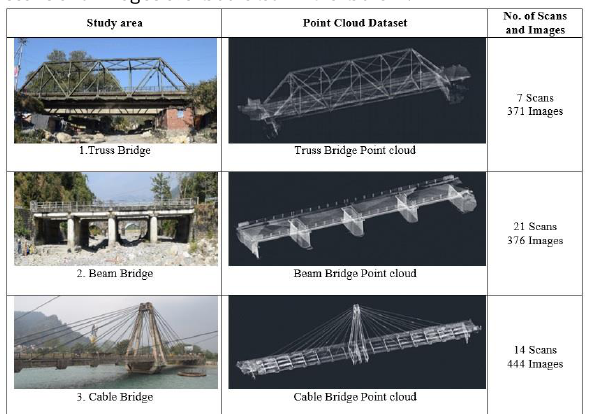
Table 1: Bridges with Point Cloud datasets and the number of scans and images acquired